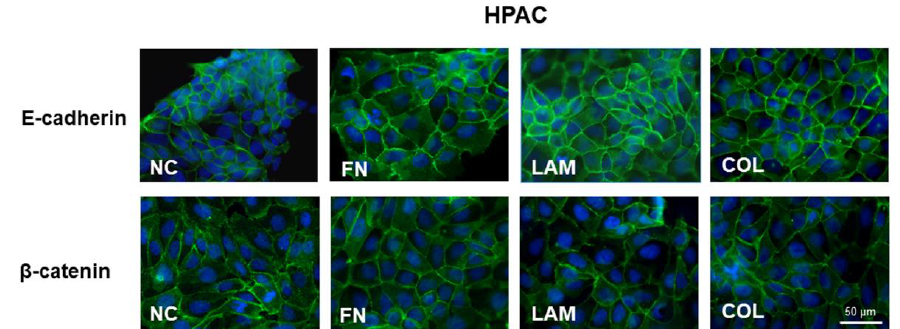
Figure 2. Immunofluorescence analysis of epithelial markers. Photomicrographs showing the expression of the epithelial markers E-cadherin and β-catenin in HPAC cells cultured on FN, LAM, COL, or without coating (NC) (original magnification 60×).